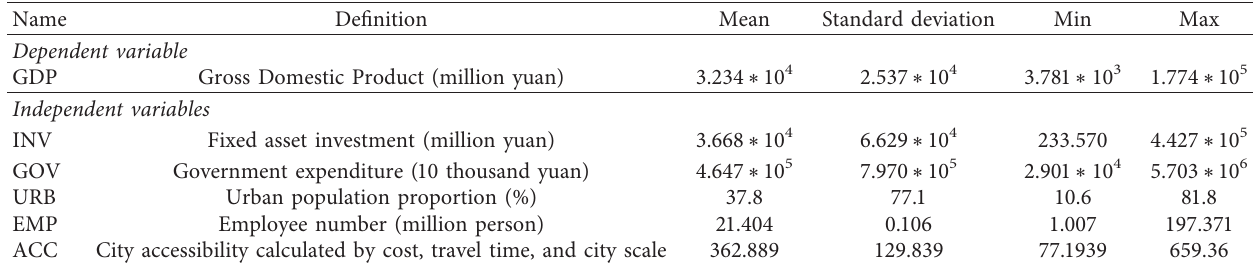
Table 1: Data description and statistics.